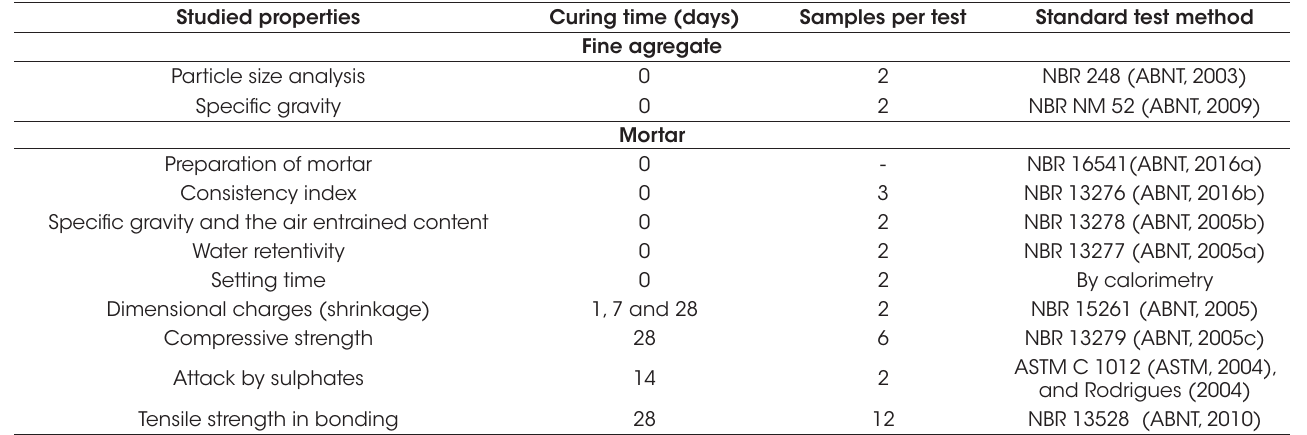
Experimental program and test